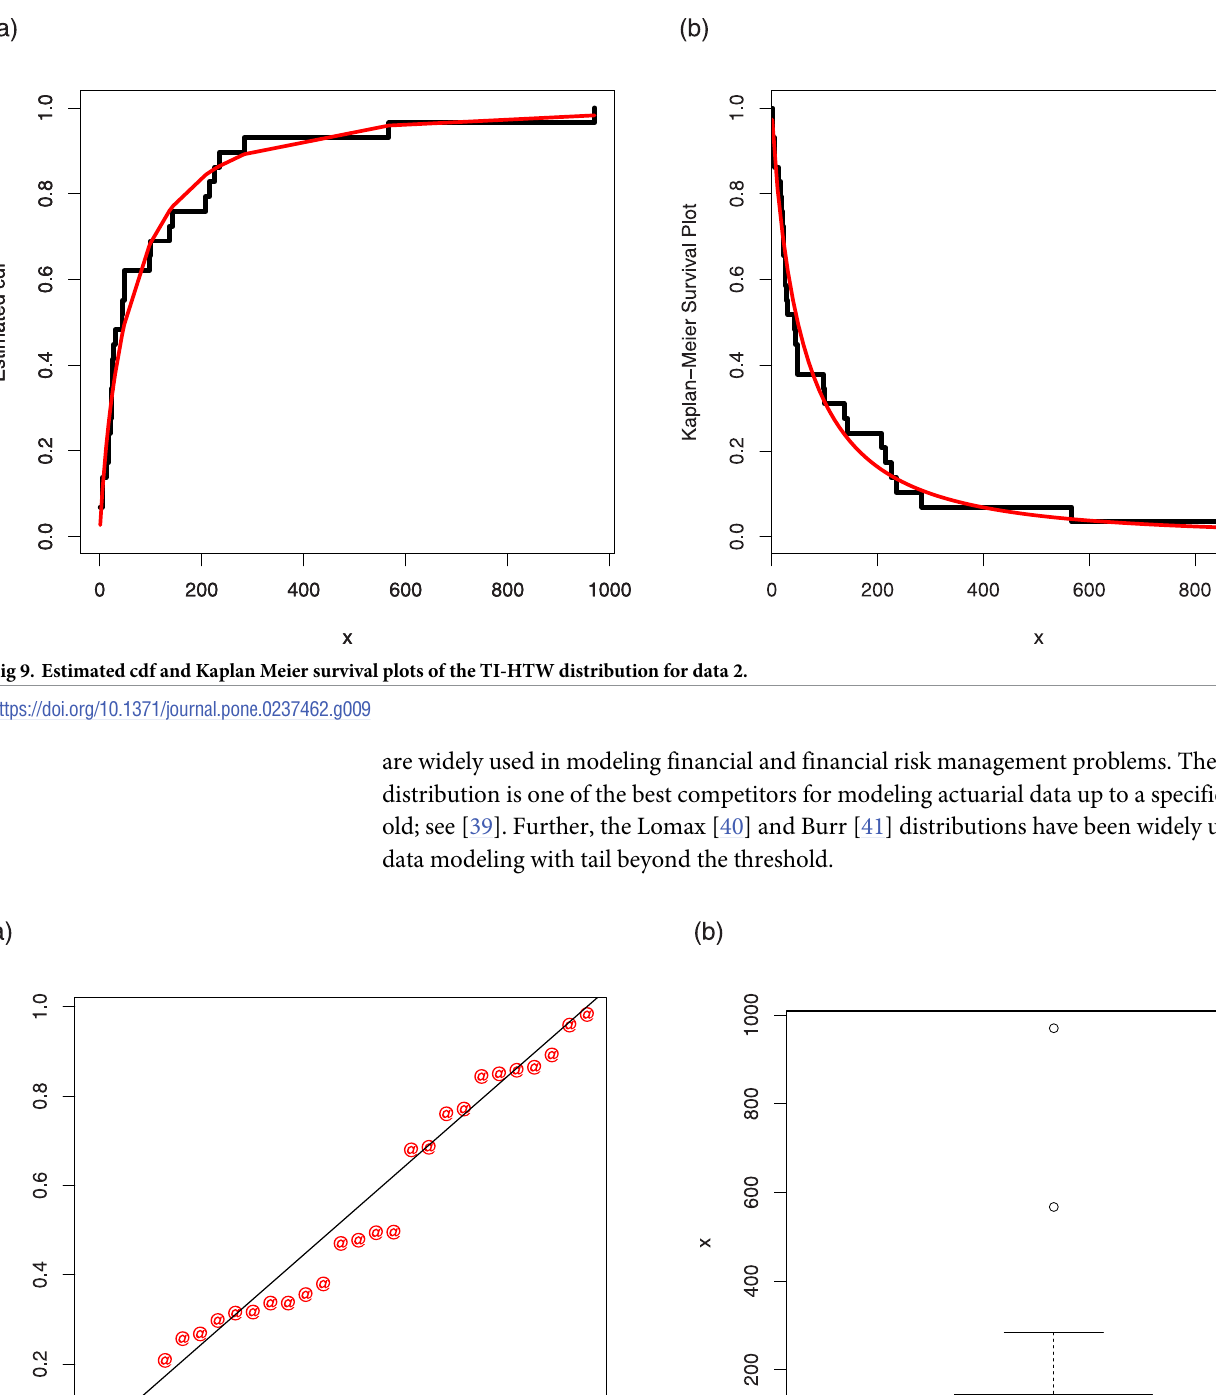
PLOS ONE | https://doi.org/10.1371/journal.pone.0237462 August 27,